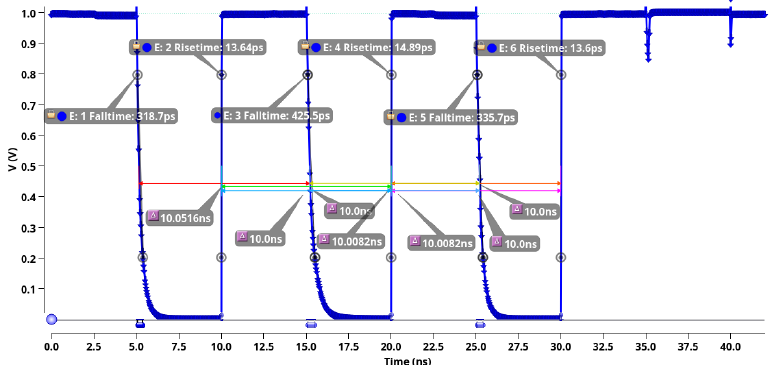
Figure 8. Transient calculation performed on the logic lock block output (Case